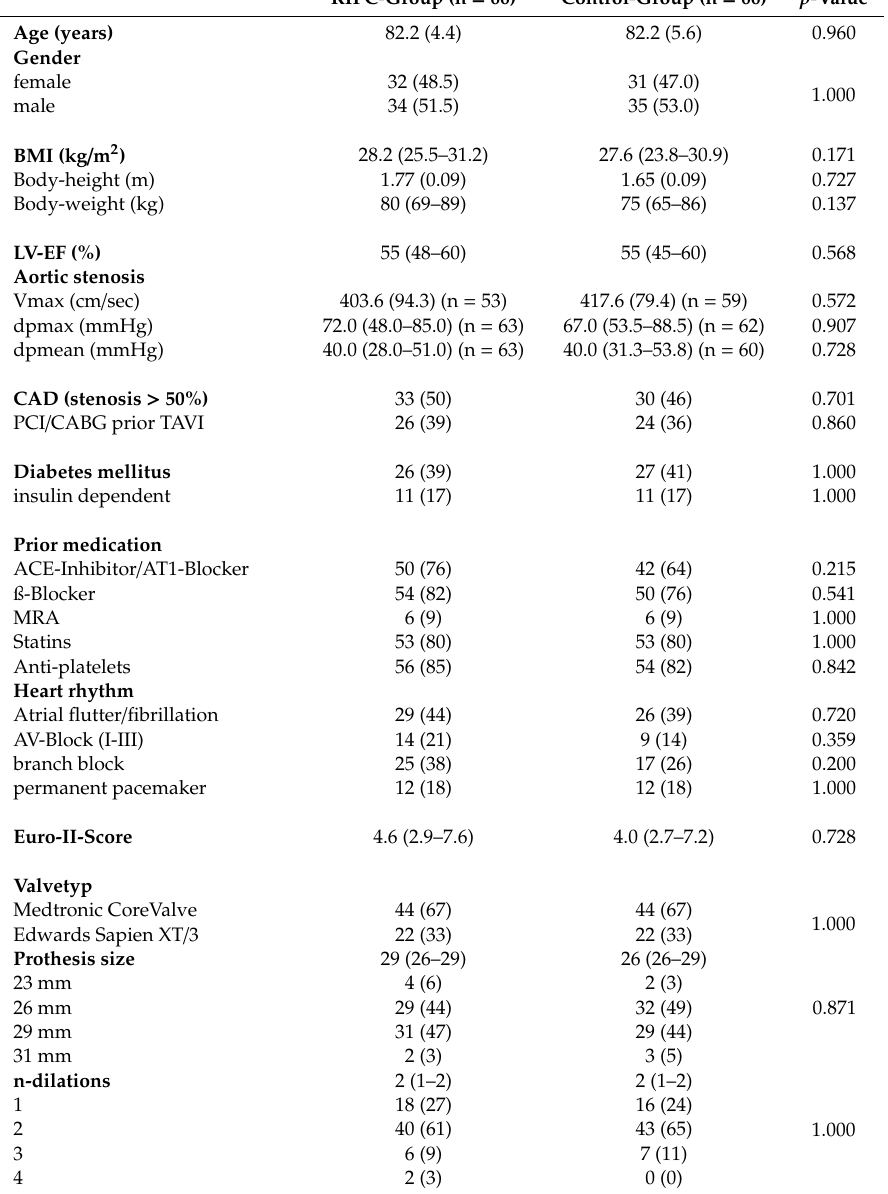
Table 1. Baseline characteristics of RIPC- and matched